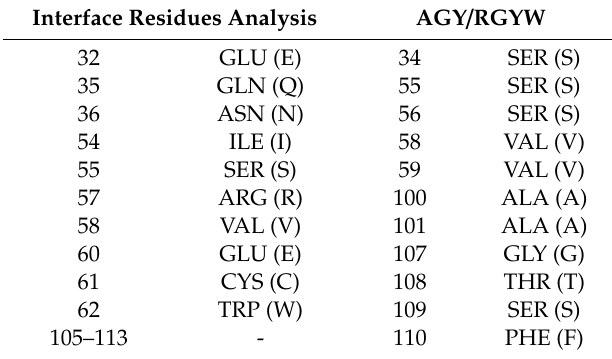
Table 1. Binding sites analyses of anti-CD47 VHH using two criteria 1